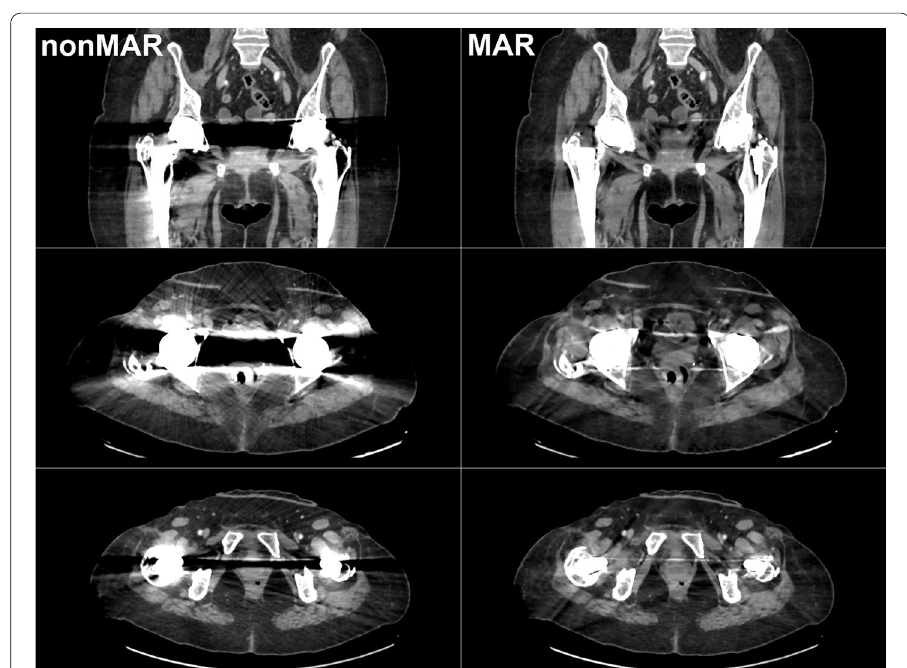
Fig. 13 CT images with and without MAR in a patient with bilateral hip prostheses. Selected coronal (upper row) and axial (second and third row) slices are shown from CT reconstructed without MAR (left column) and CT reconstructed with MAR (right